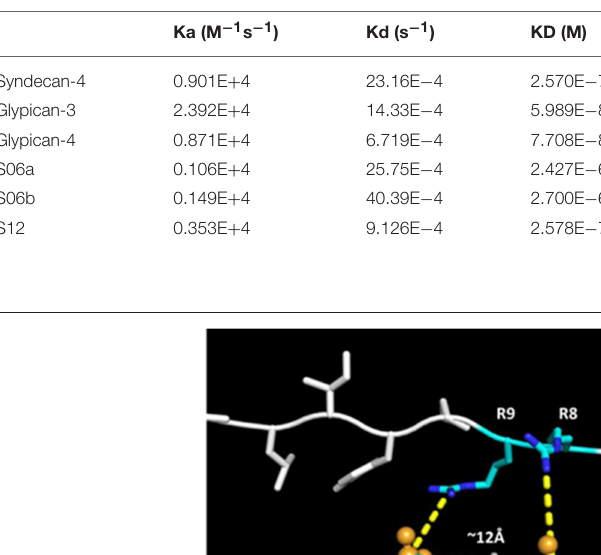
Frontiers in Oncology |